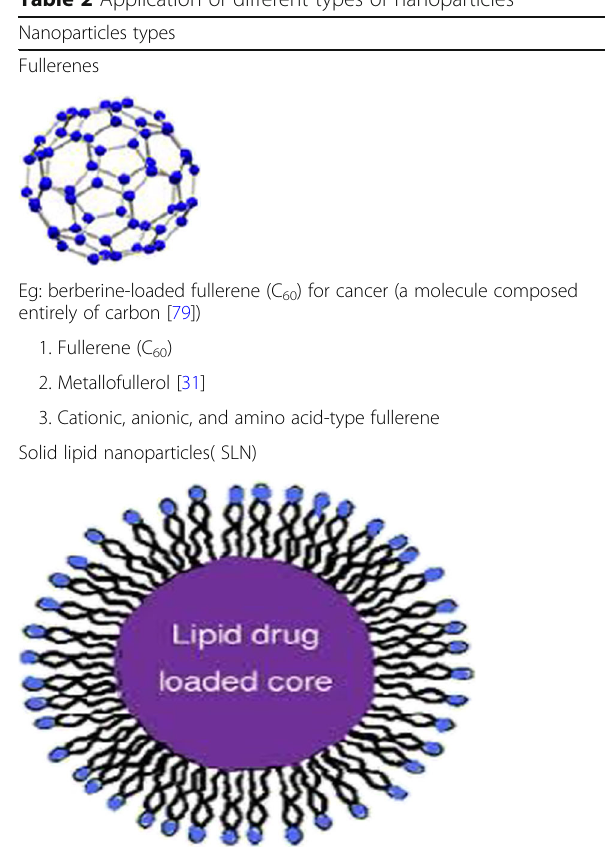
Table 2 Application of different types of